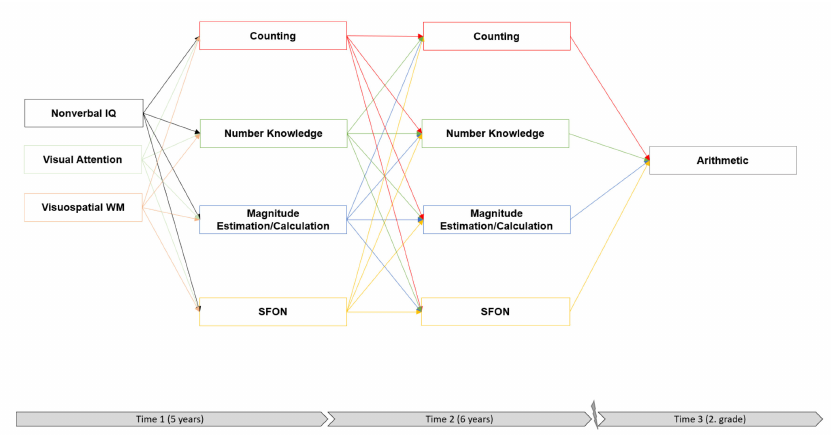
Figure 1. Theoretical